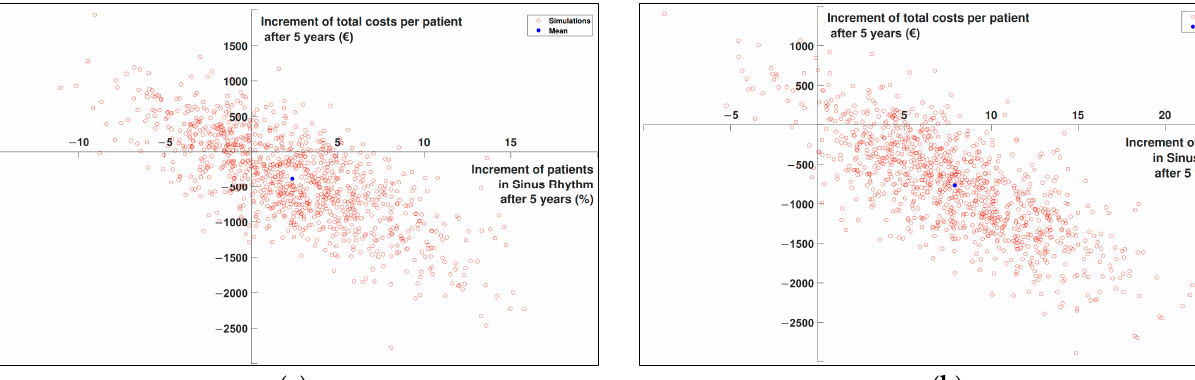
Figure 5. Cost-effectiveness plane ( a ) Comparison of current situation with an increase of 25% in effectiveness of CA. ( b ) Comparison of current situation with an increase of 25% in effectiveness of CA and an increase of 5% in patients undergoing CA.